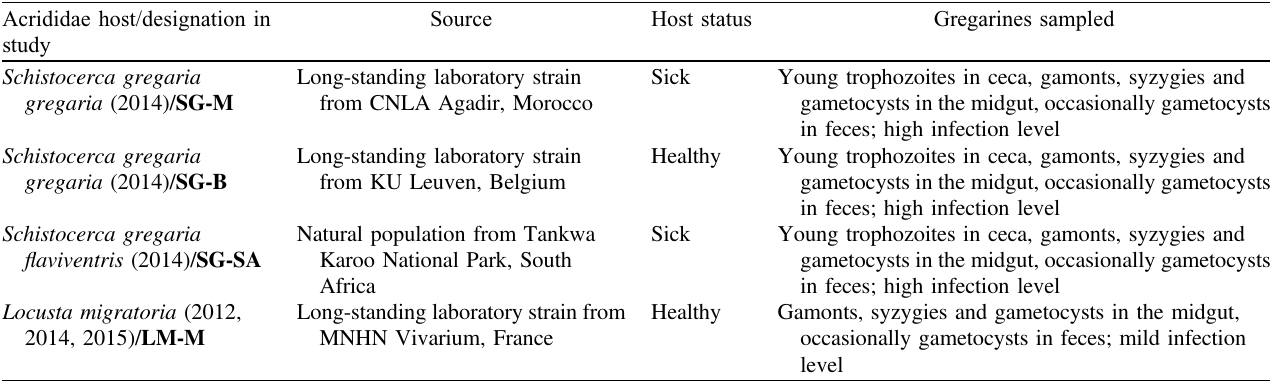
Table 2. Acrididae hosts used in this study, sampling dates, host status and sampled gregarines. “ Sick ” hosts died rapidly (within days) in laboratory conditions in contrast to “ healthy ” hosts that were maintained for